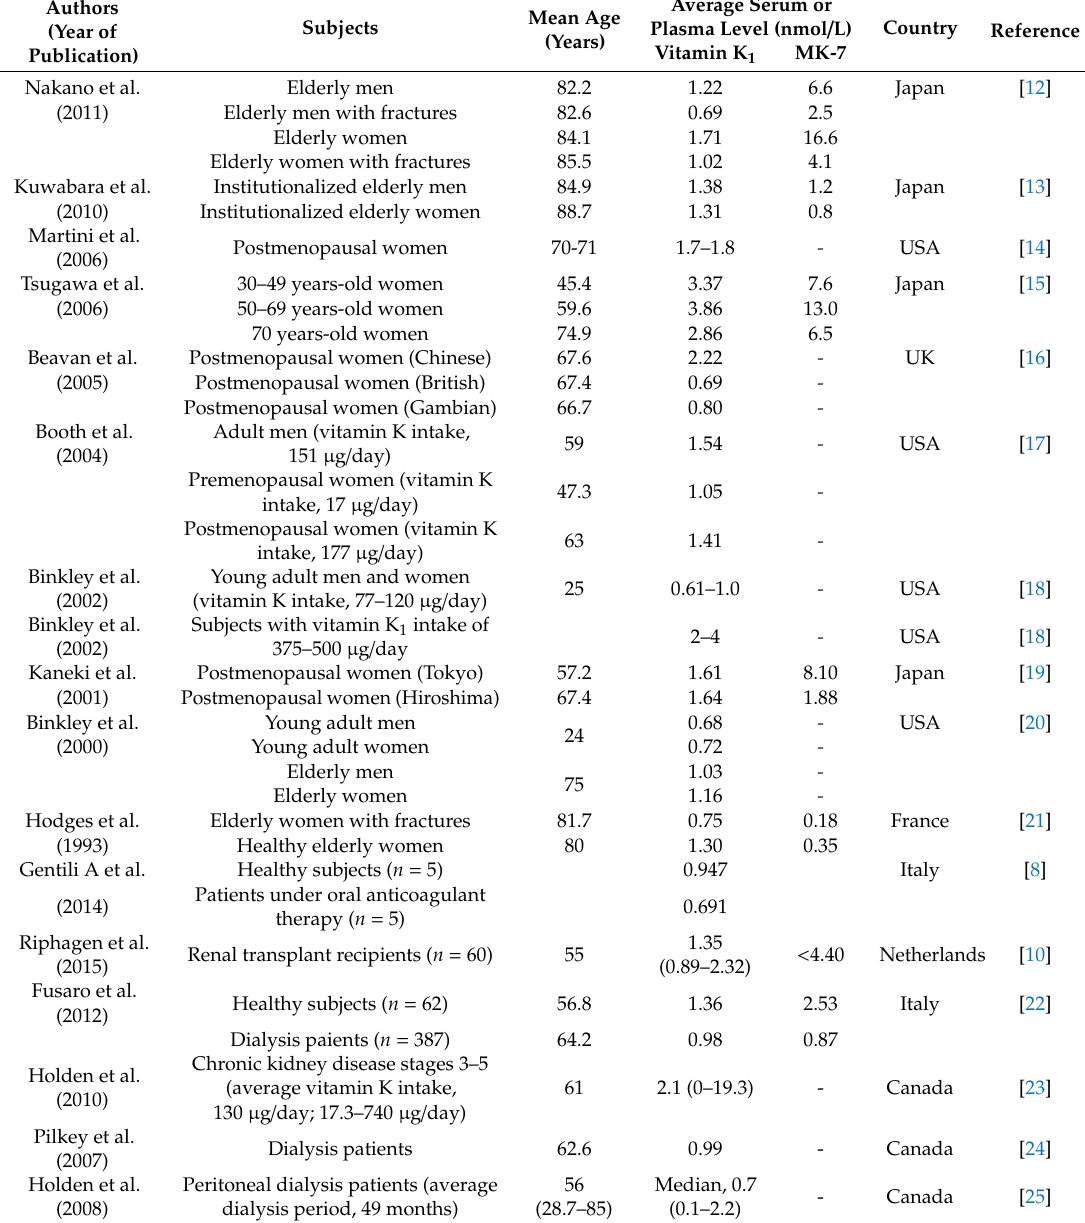
Table 1. Phylloquinone (vitamin K 1 ) and menaquinone-7 (MK-7) levels in the blood